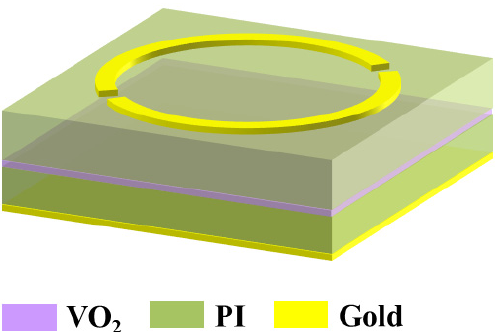
Figure 14. Nonstructured VO 2 film-based metamaterial multi-functional polarization structure. Adapted with permission from Ref. [156], 2022, Copyright the